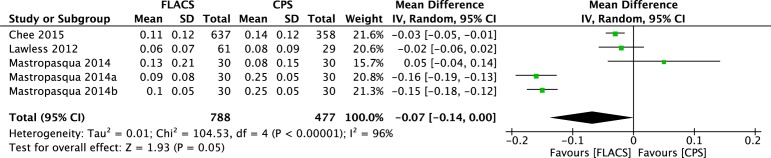
Forest plot comparison of MAE of spherical equivalent refraction after treatment with FLACS and CPS.